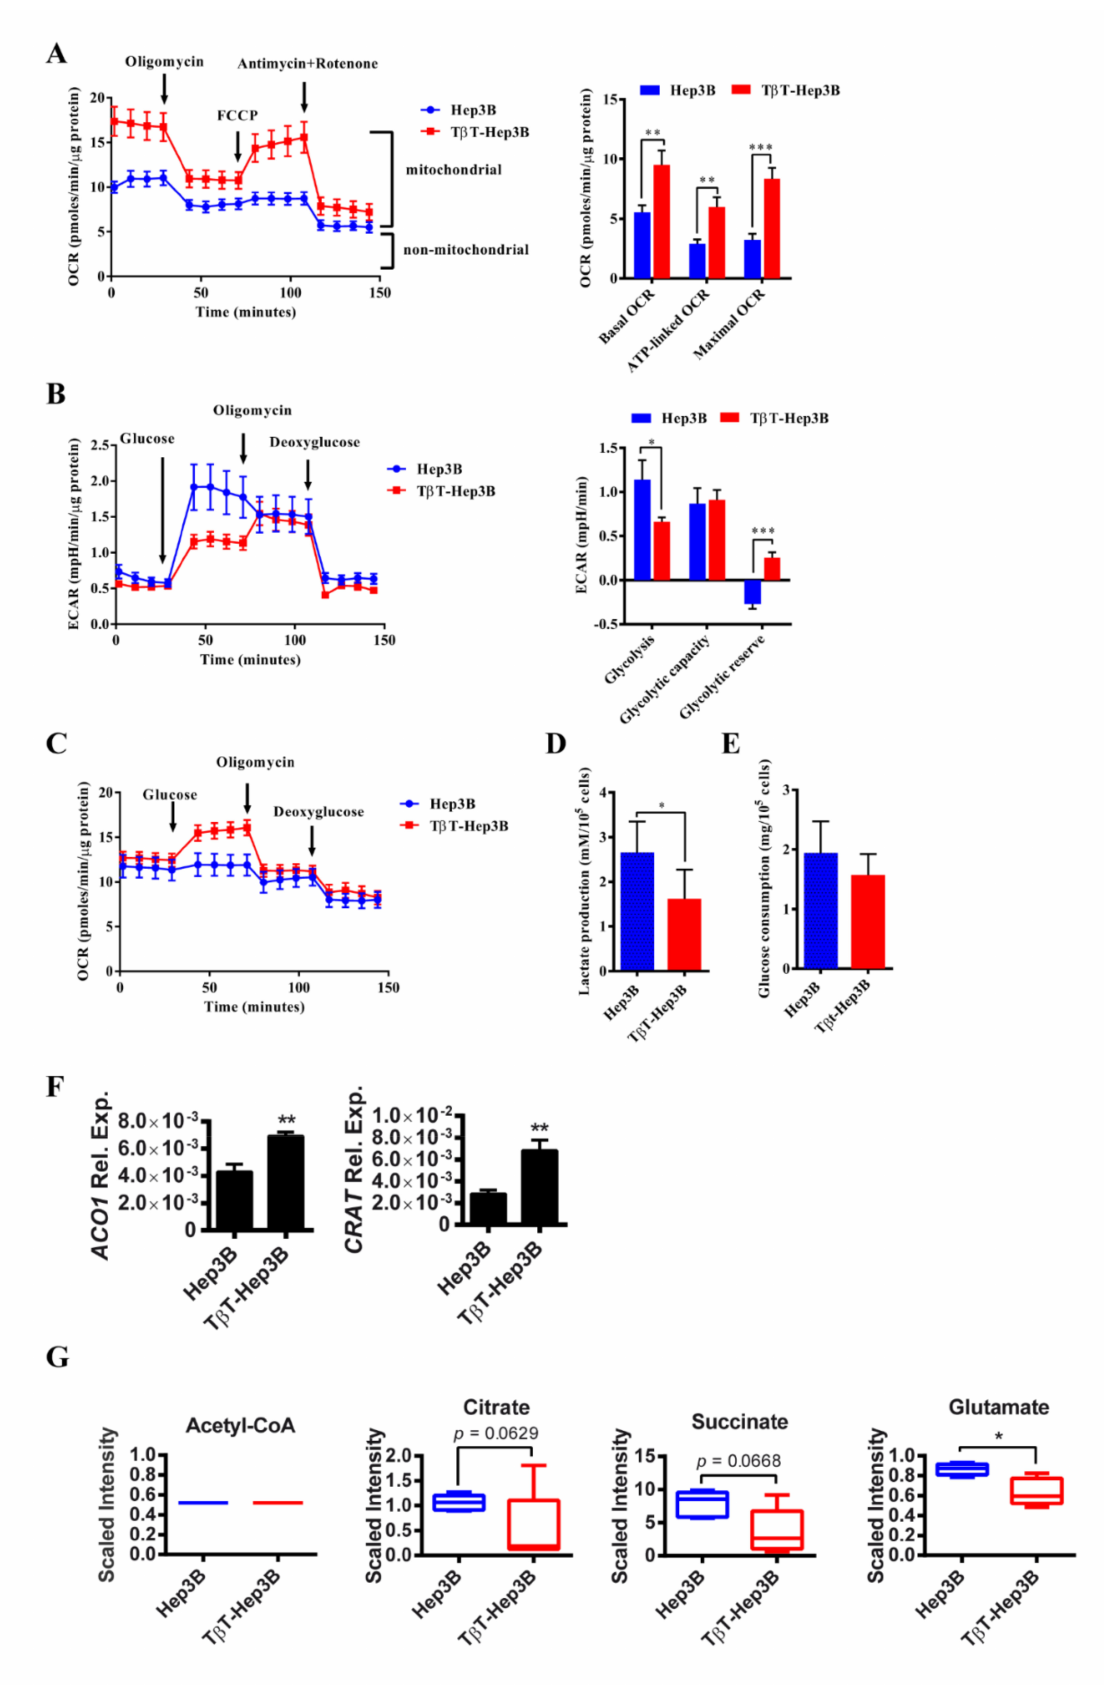
Figure 5. A switch from glycolysis to OXPHOS is observed in T β T-Hep3B